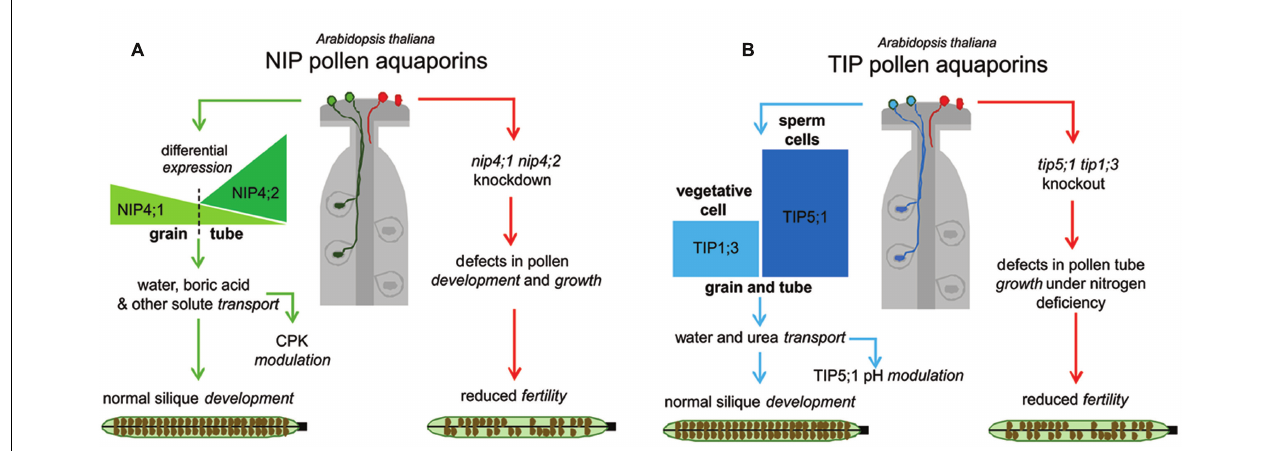
FIGURE 2 | Global models for the roles of pollen specific aquaporins (AQPs) in reproduction. (A) In the presence of NIP4;1 and NIP4;2, plant fertility is normal (left, green pathway). NIP4;1 and NIP4;2 expression peaks differ temporally. In the absence of NIPs AQPs, (right, red pathway) plant fitness is reduced (fewer seeds and shorter siliques due to non-fertilized ovules). The nip4;1nip4;2 knockdown showed defects in pollen development, maturation, germination, and pollen tube growth. (B) In the presence of TIP1;3 and TIP5;1 there is normal fertilization (left, blue pathway). TIP1;3 and TIP5;1 expression patterns are also differentially localized in vegetative and sperm cells, respectively. In the absence of both TIPs (right, red pathway), plant fitness is reduced under nitrogen deficiency (in agreement with their substrate specificity) due to defects in pollen tube